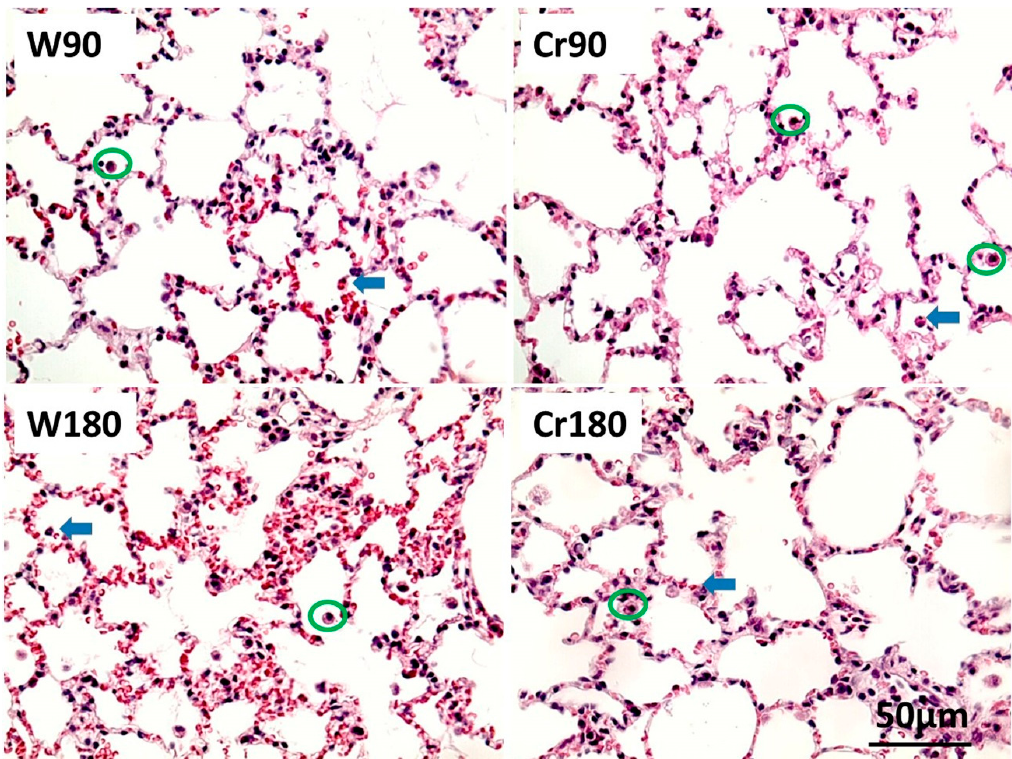
Figure 4. Mononuclear and polymorphonuclear cells in the lung tissue. W90, control/water + 90 min of ischemia; Cr90, creatine + 90 min of ischemia; W180, control/water + 180 min of ischemia; Cr180, creatine + 180 min of ischemia. Green circle, mononuclear cells; blue arrow, polymorphonuclear cells (H.E., 400×).